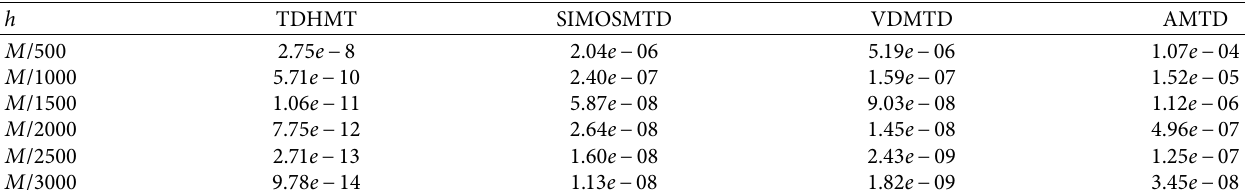
Table 7: Comparison of the absolute errors at the end point of TDHMTwith absolute error of other existing methods, namely, SIMOSMTD, VDMTD, and AMTD for Example 4. h